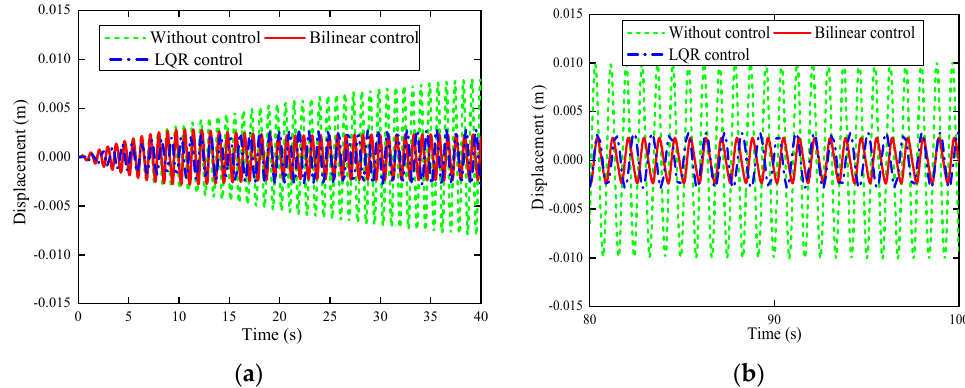
Figure 3. Time history of displacement and force at mid-span under harmonic excitation. ( a ) Time history of displacement of the first 40 s under forced vibration. ( b ) Time history of steady-state displacement.